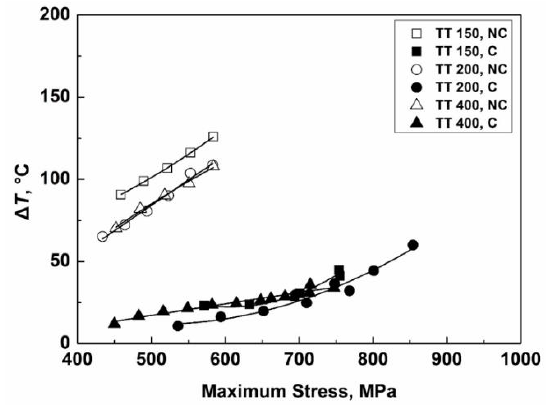
Figure 6. Average values of temperature rise as a function of the maximum stress by the UA and UA-NC methods for three material conditions.